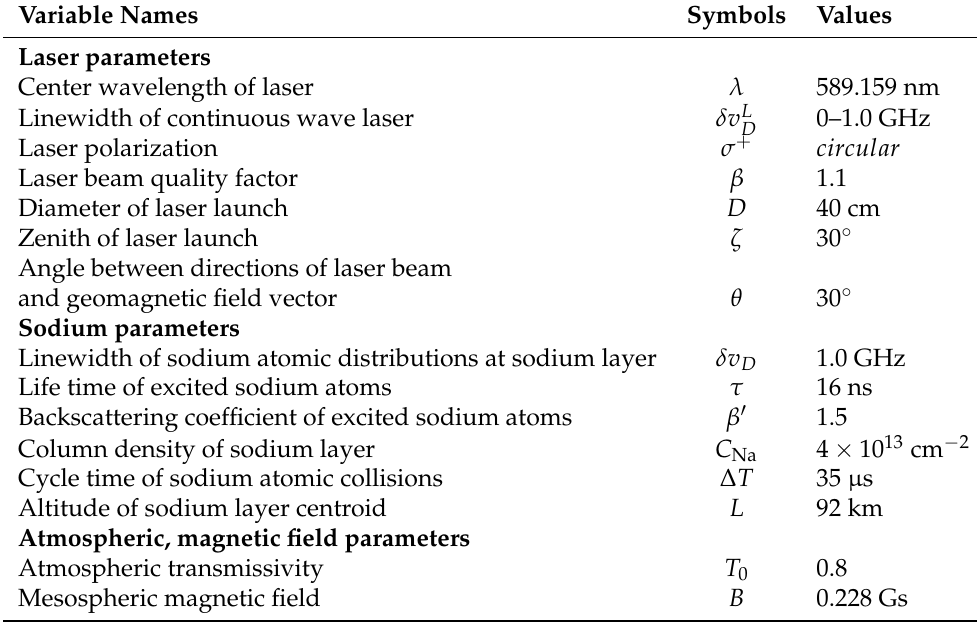
Table 1. Numerical simulation parameters.